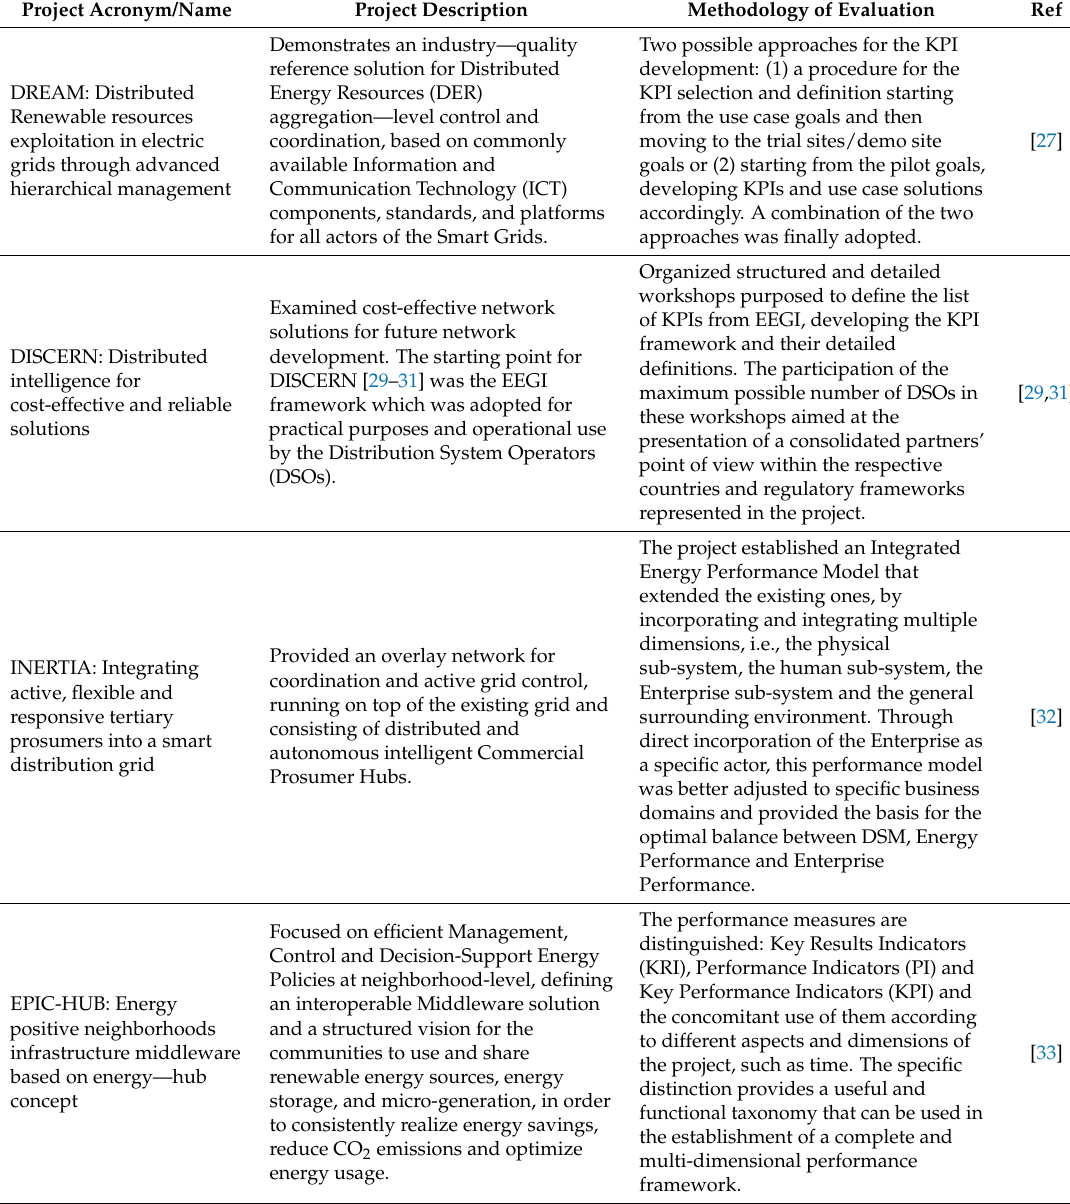
Table 2. Technology assessment methodologies by European Commission (EC)-funded